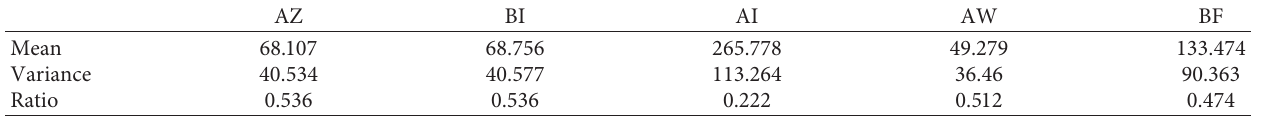
Table 6: The operation status of flight support service